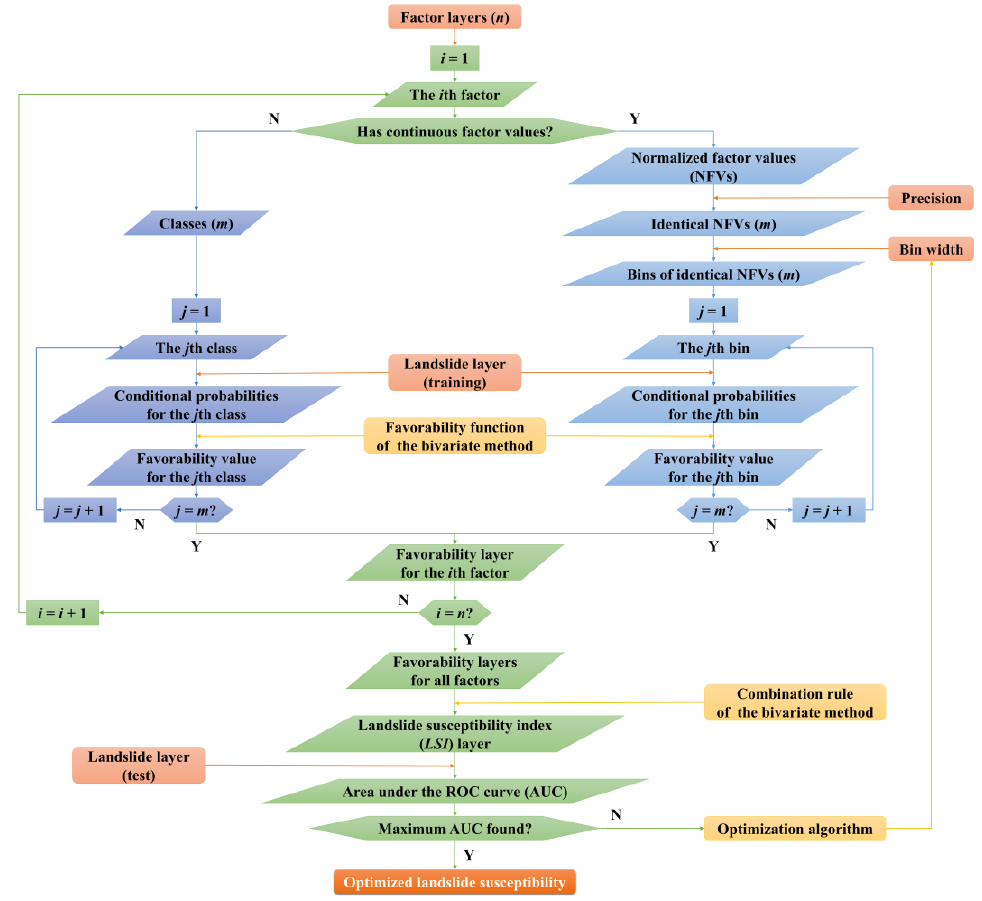
Figure 3. General optimization framework for conditional-probability-based bivariate methods of landslide susceptibility analysis.